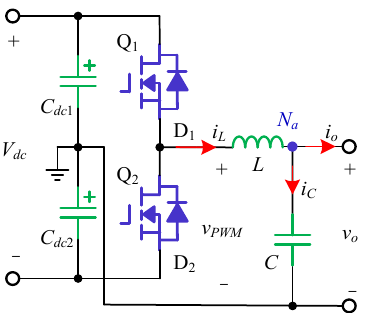
Figure 1. The circuit of a single ‐ phase half ‐ bridge inverter.